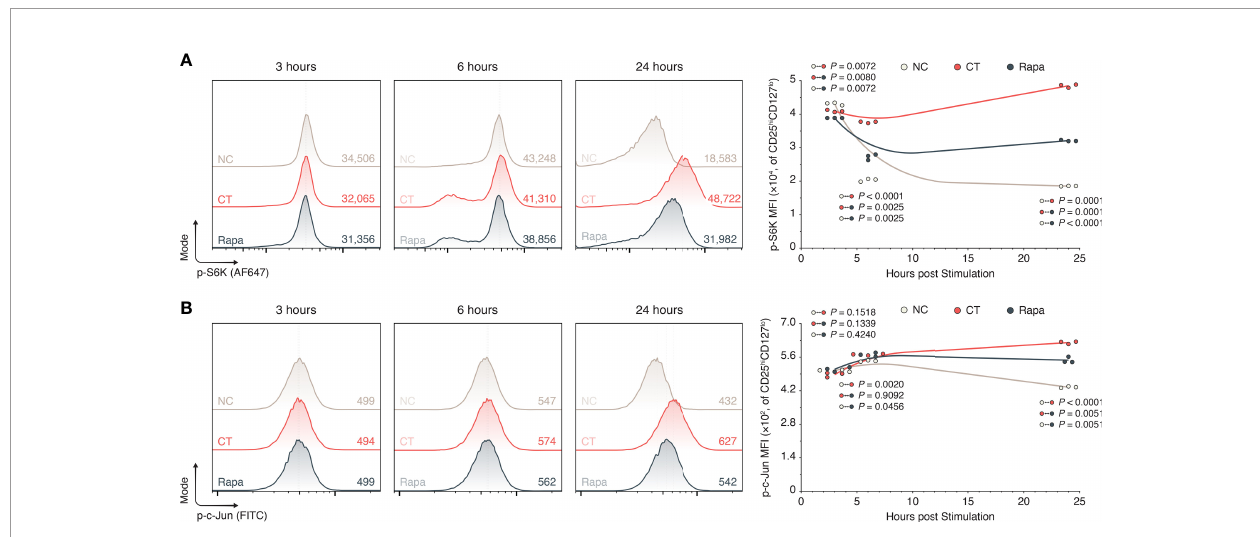
FIGURE 3 | mTORC1 inhibition attenuates S6K and c-Jun phosphorylation. Human T regs were isolated and expanded in a 24-hour cell culture window without inclusions (NC), with a -CD3, a -CD28, and IL-2 (CT), or with CT stimulants and 100 nM rapamycin (Rapa). (A) Flow histograms of p-S6K expression among CD25 hi CD127 lo T regs , including inset mean fl uorescence intensities (MFIs) and the 24-hour period XY plot (n = 3 technical replicates/condition/timepoint; 1 representative experiment of 3). (B) Flow histograms of p-c-Jun expression among CD25 hi CD127 lo T regs , including inset mean fl uorescence intensities (MFIs) and the 24-hour period XY plot (n = 3 technical replicates/condition/timepoint; 1 representative experiment of 3). All individual datapoints are displayed. P values were calculated using mixed-effects model analyses with the Geisser-Greenhouse correction followed by Holm-S ̌ ı ́ da ́ k multiple comparison tests. AF647, Alexa Fluor 647; CT, control; MFI, mean fl uorescence intensity; NC, negative control; Rapa,